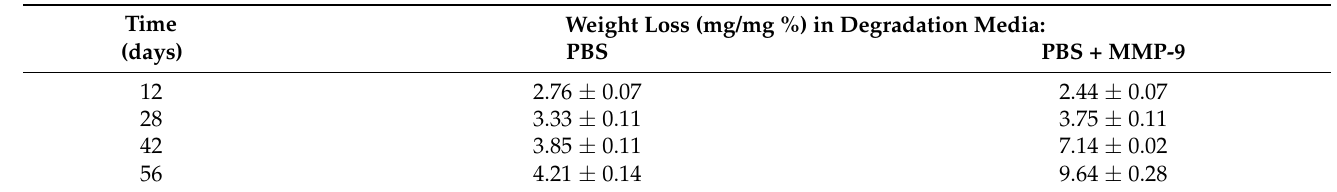
Table 2. Gravimetric weight loss (mg/mg %) of PHBHV/OLE fibers in different media: PBS and PBS added with MMP-9. Data are expressed as mean ± SD ( n = 4).